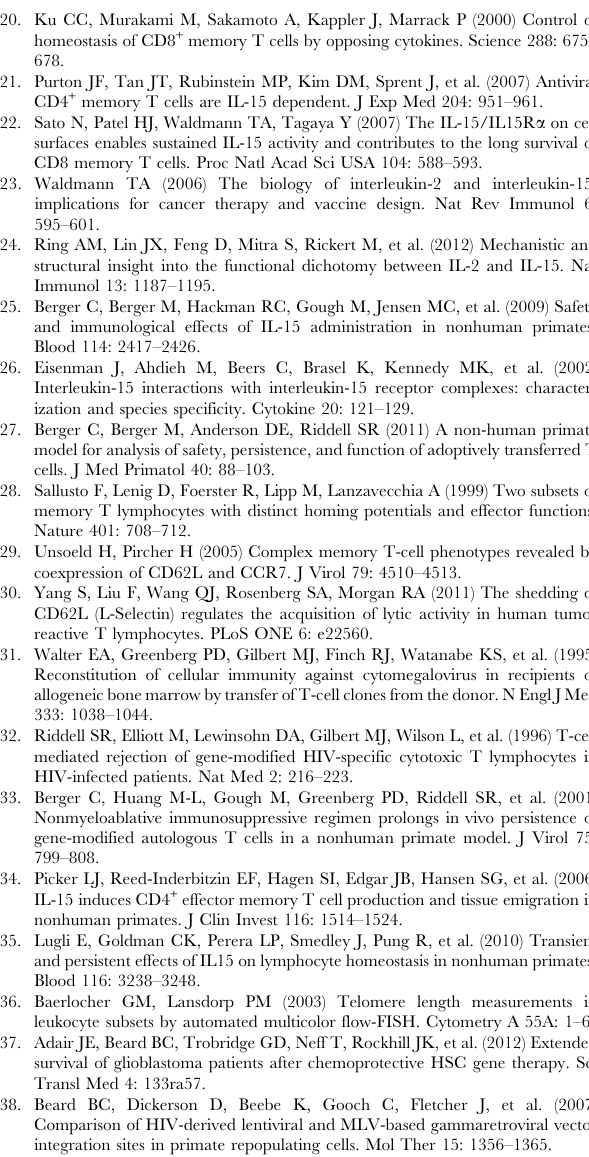
Figure S4 Polyclonal CD8 + T CM/E transferred with IL-15 acquire memory-marker and migrate to T M